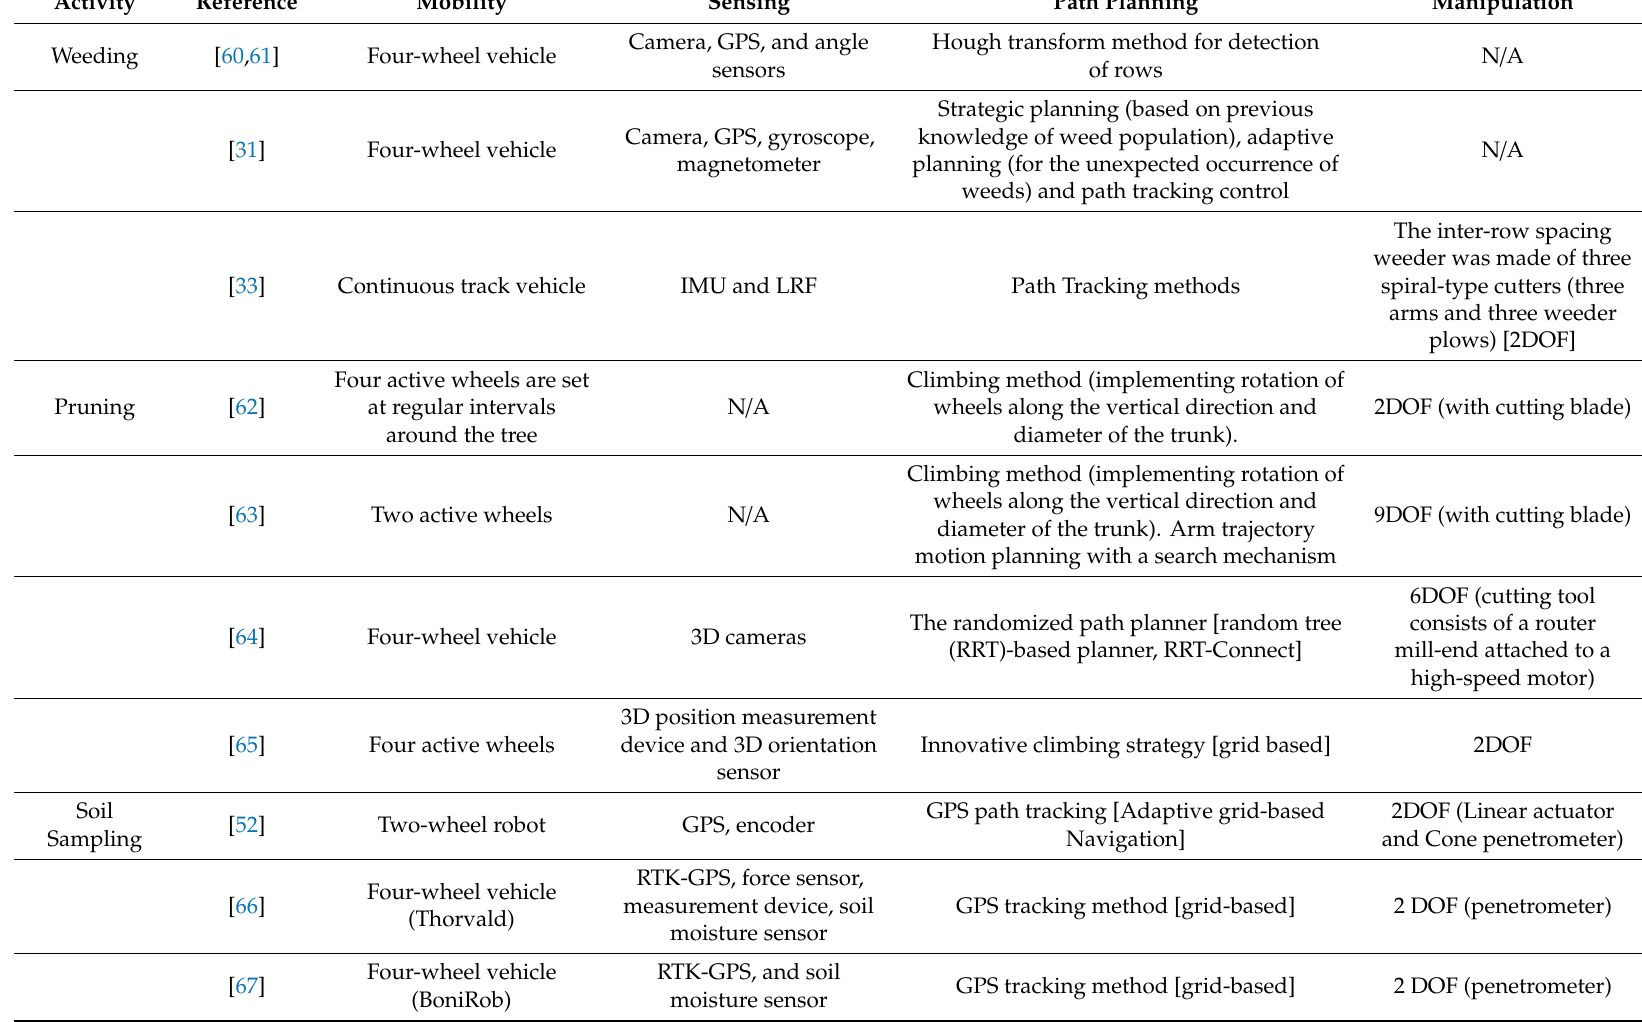
Table 3. Other agricultural robots for weeding, soil sampling, scouting / phenotyping, pruning, spraying, and